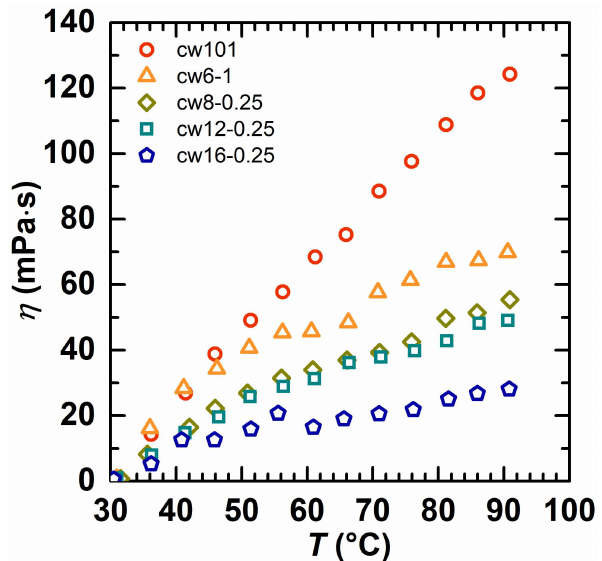
Figure 8. The reduced apparent viscosity as a function of temperature for cw101 and HAPAM with different hydrophobes (the copolymer concentration was fixed at 1 wt% in all solutions).